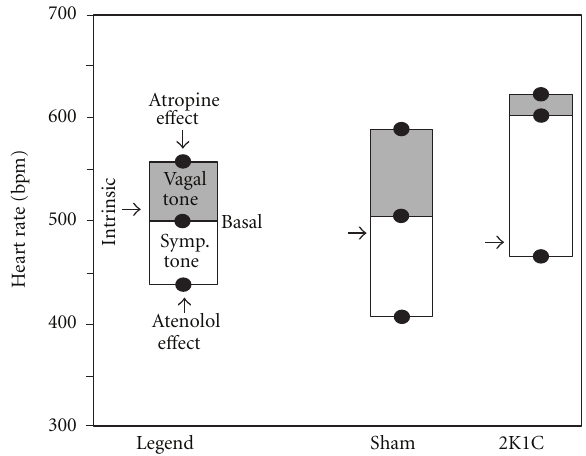
Figure 2: Typical imbalance of cardiac autonomic tones in the angiotensin-dependent hypertensive mouse. The cardiovagal tone is represented by the tachycardia observed following the administra- tion of the muscarinic blocker atropine, and the cardiac sympathetic tone is represented by the bradycardia observed after administering the β -adrenergic blocker atenolol. The heart rate after the double blockade indicates the intrinsic heart